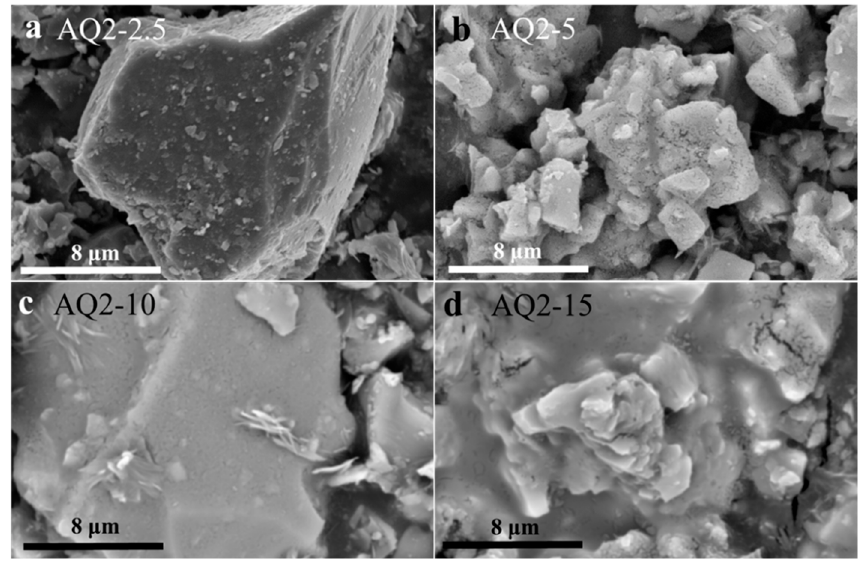
Figure 7. SEM images of quartz-2 activated with various contents of NaOH: ( a ) AQ2-2.5, ( b ) AQ2- 5, ( c ) AQ2-10 and ( d ) AQ2-15. ( c ) AQ2-10 and ( d )